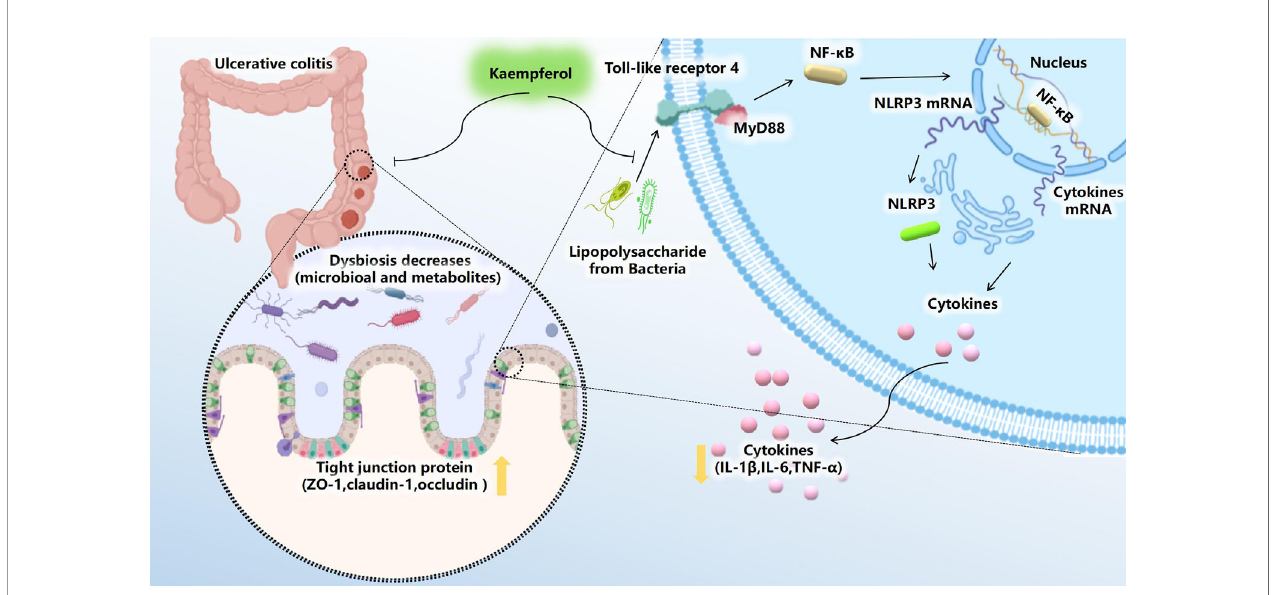
FIGURE 9 | Kae exerts excellent anti-UC effects via gut microbiota pathways related to the LPS-TLR4-NF- k B core pathway. Kae reduces LPS levels by inhibiting the proliferation of pathogenic Gram-negative bacilli, thereby altering the metabolic pro fi le, blocking NF- k B pathway activation, improving intestinal tight junction integrity, inhibiting pro-in fl ammatory factors, and increasing antioxidants, thus decreasing DSS-induced colonic in fl